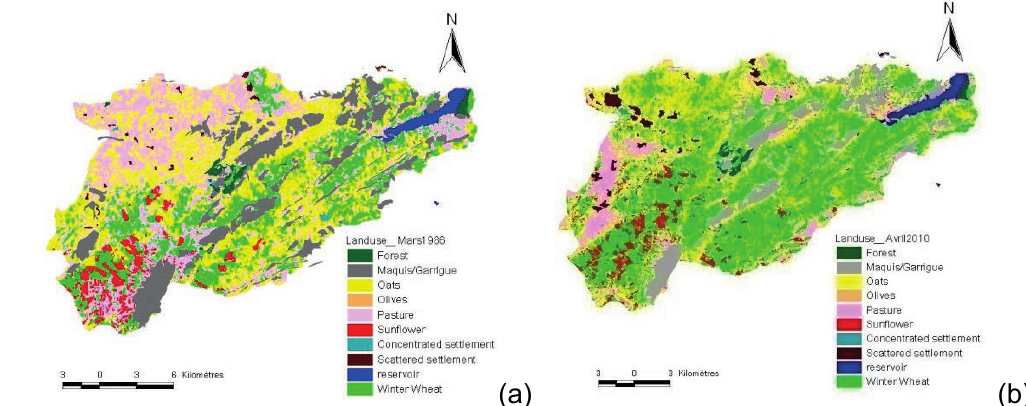
Fig. 4 Land use on March 1986 (a) and April 2010